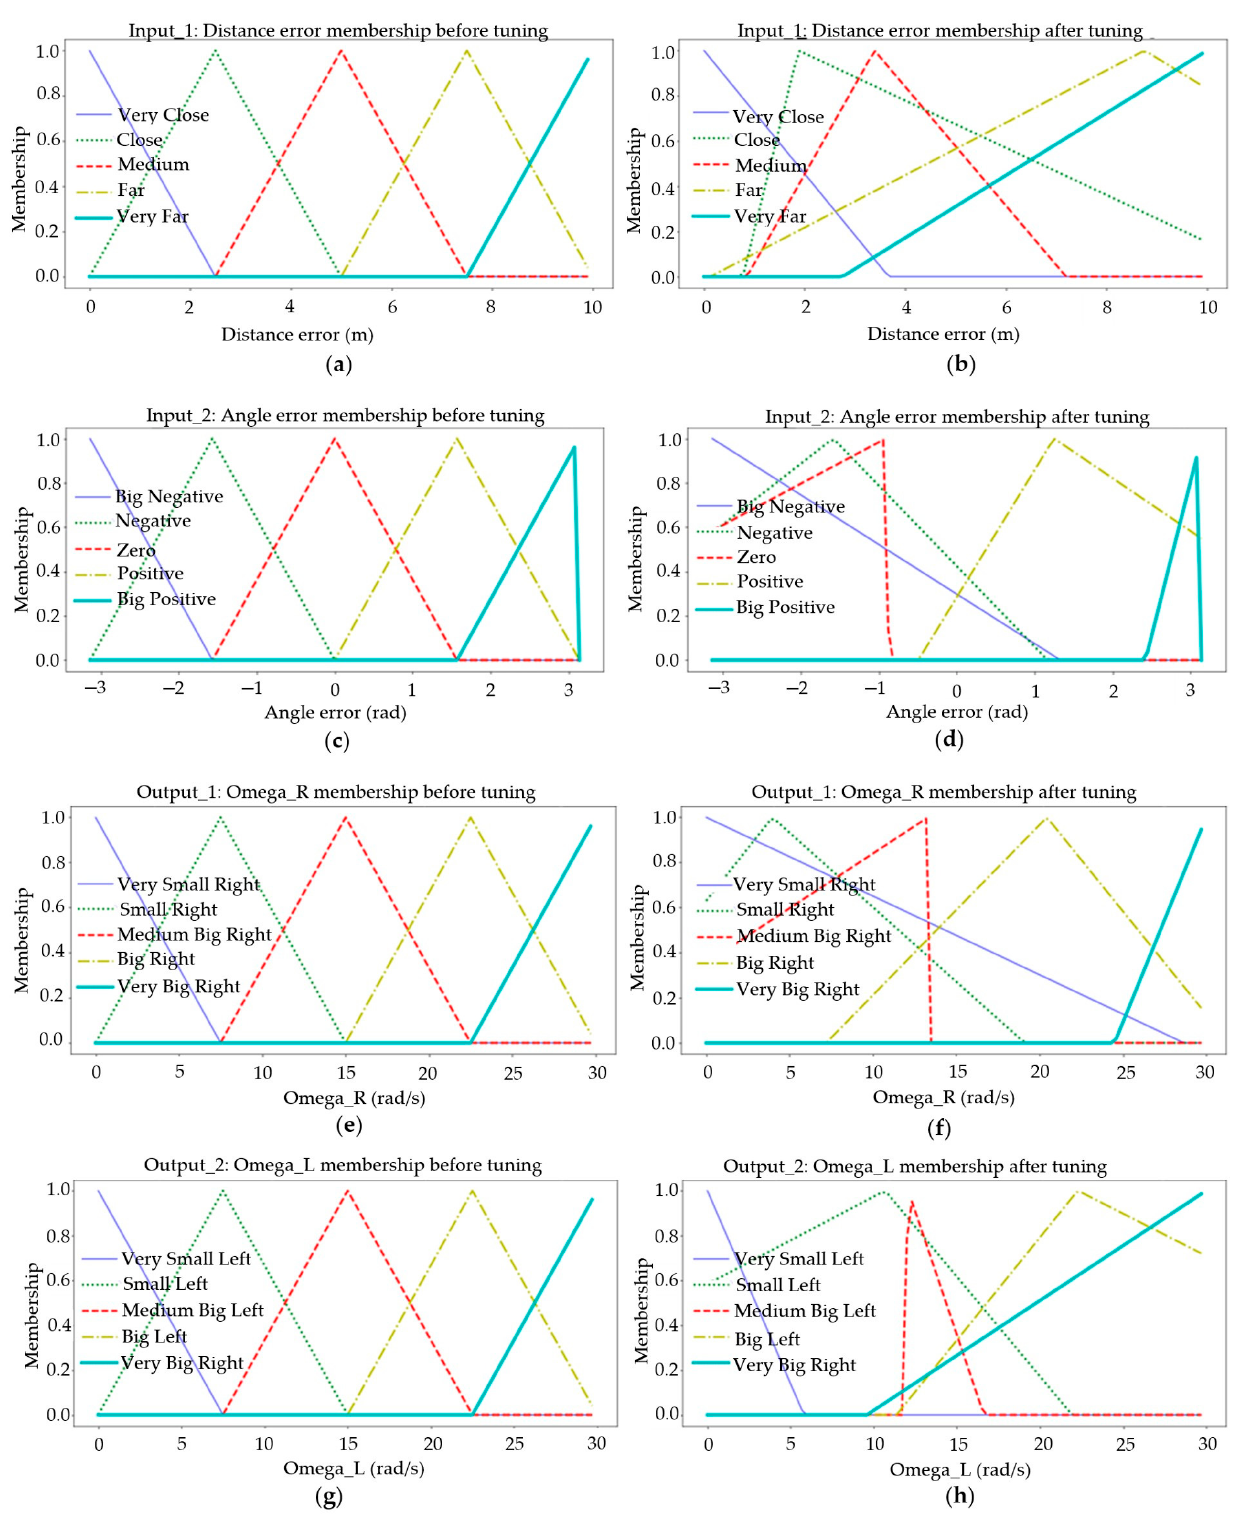
Figure 14. The membership function used for the zigzag path. ( a ) The distance membership functions before tuning; ( b ) The distance membership functions after tuning; ( c ) The angle membership functions before tuning; ( d ) The angle membership functions before tuning; ( e ) The output _1 (Omega_R) membership functions before tuning; ( f ) The output _1 (Omega_R) membership functions after tuning; ( g ) The output _2 (Omega_L) membership functions before tuning; ( h ) The output _2 (Omega_L) membership functions after